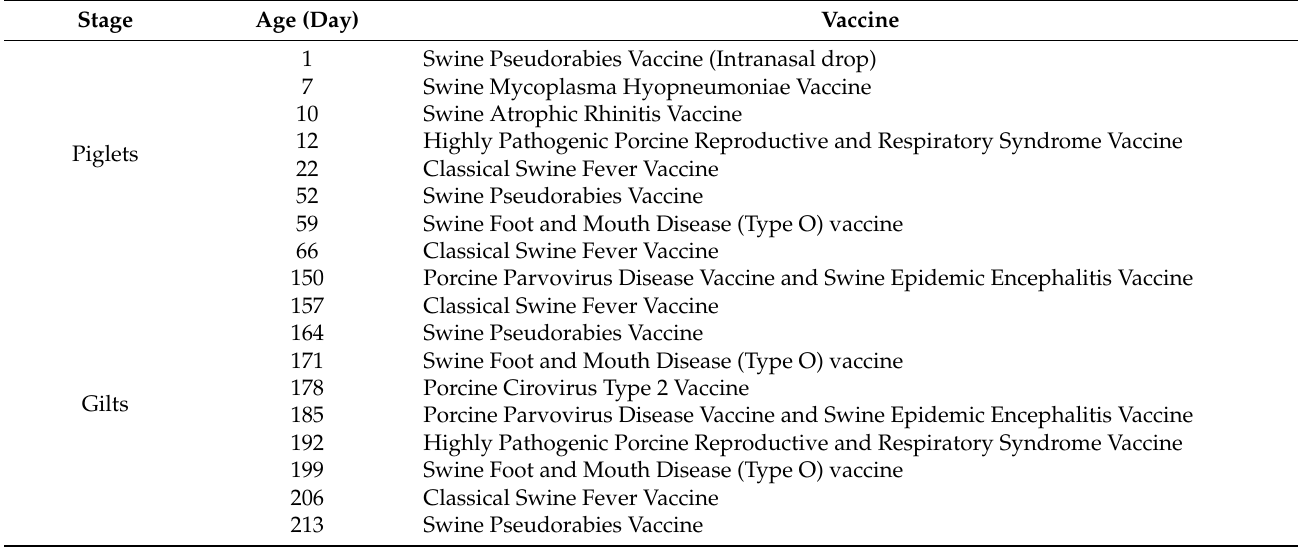
Table 1. Immunization procedure of Landrace × Yorkshire sows used in this